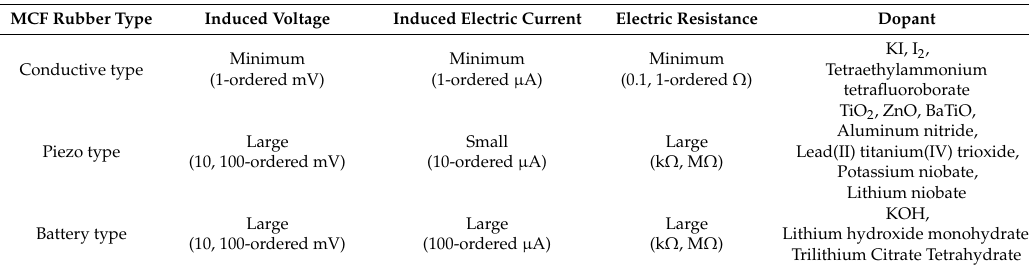
Table A1. Three types of electrolytically polymerized MCF rubber mainly divided by kinds of dopant